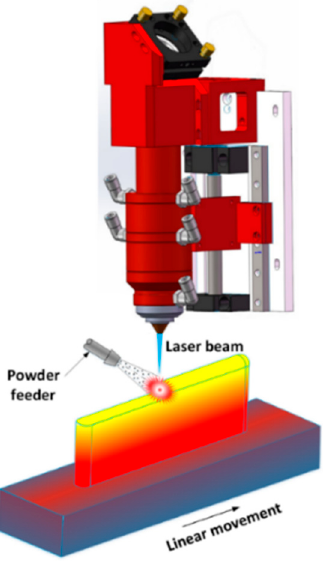
Figure 1. Schematic diagram of the laser-aided direct energy deposition process.